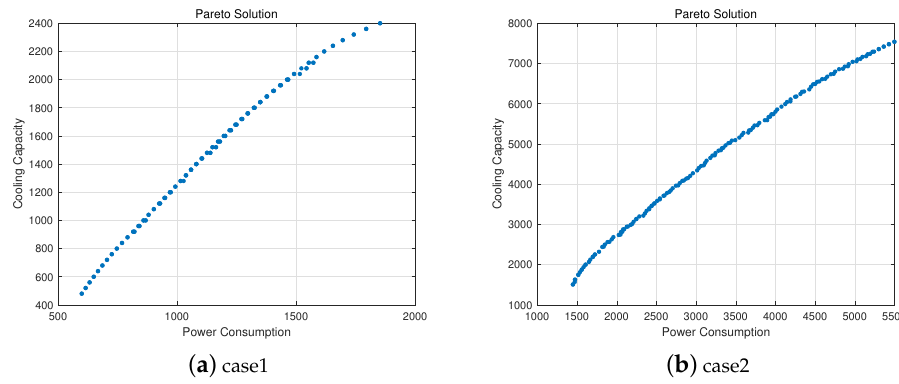
Figure 5. Solutions with INSGA-II on parallel chiller’s cooling capacity distribution problem.